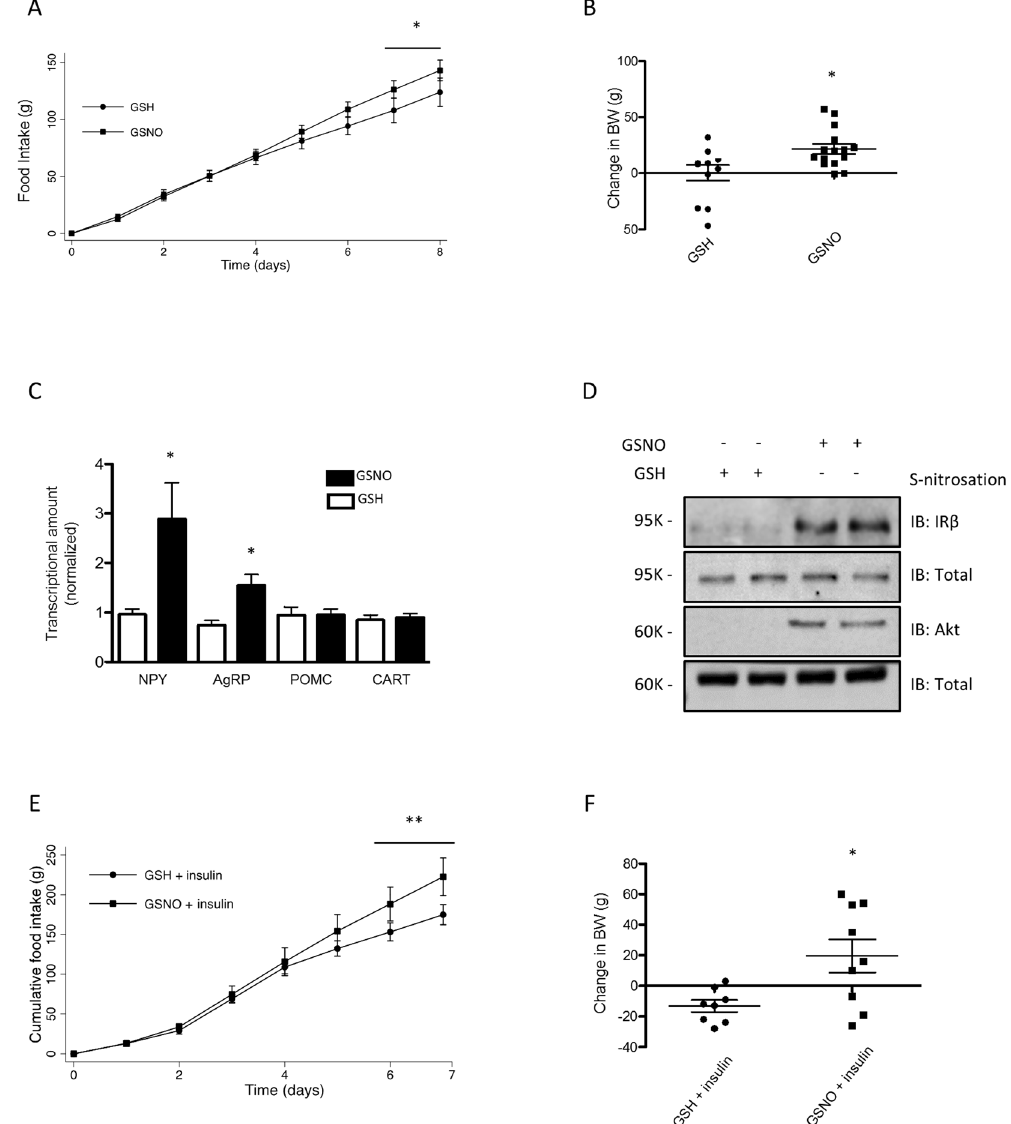
treated group (n = 10–15 animals per